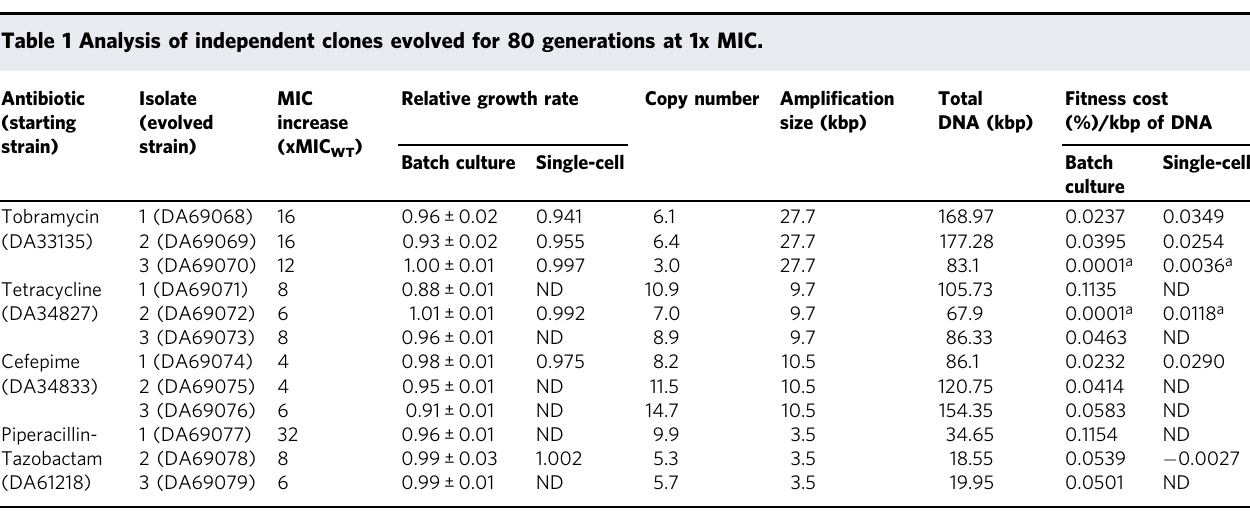
MIC was determined based on 3 biological and 1 technical replicates. Relative growth rates were determined based on 3 technical and 1 biological (batch culture) and 1 biological and 1 technical (single- cell) replicates. ND not determined. a These strains were not considered in the calculations of average cost per kbp of DNA since they had additional single mutations of unknown effects in their